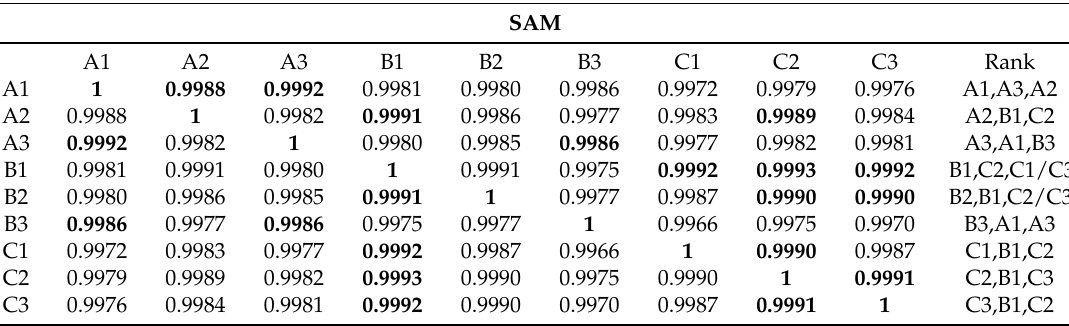
Table 5. The performance of SAM for the AVIRIS